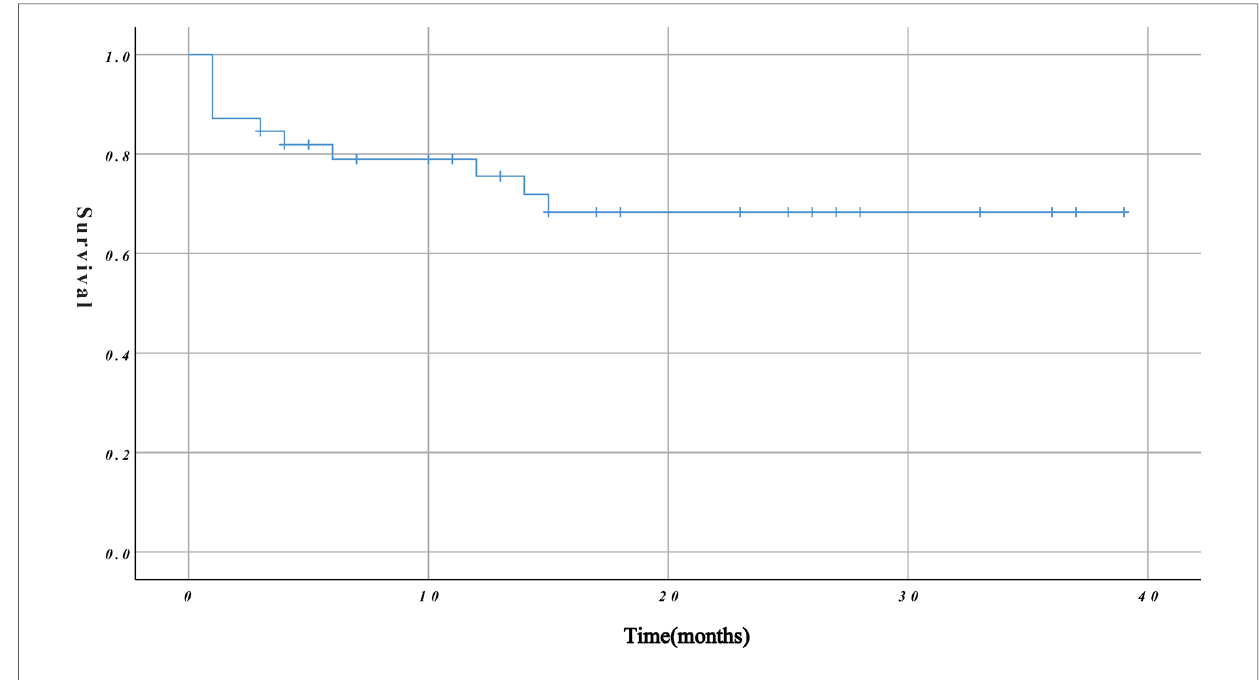
FIGURE 3 Kaplan – Meier curves for overall survival rate.